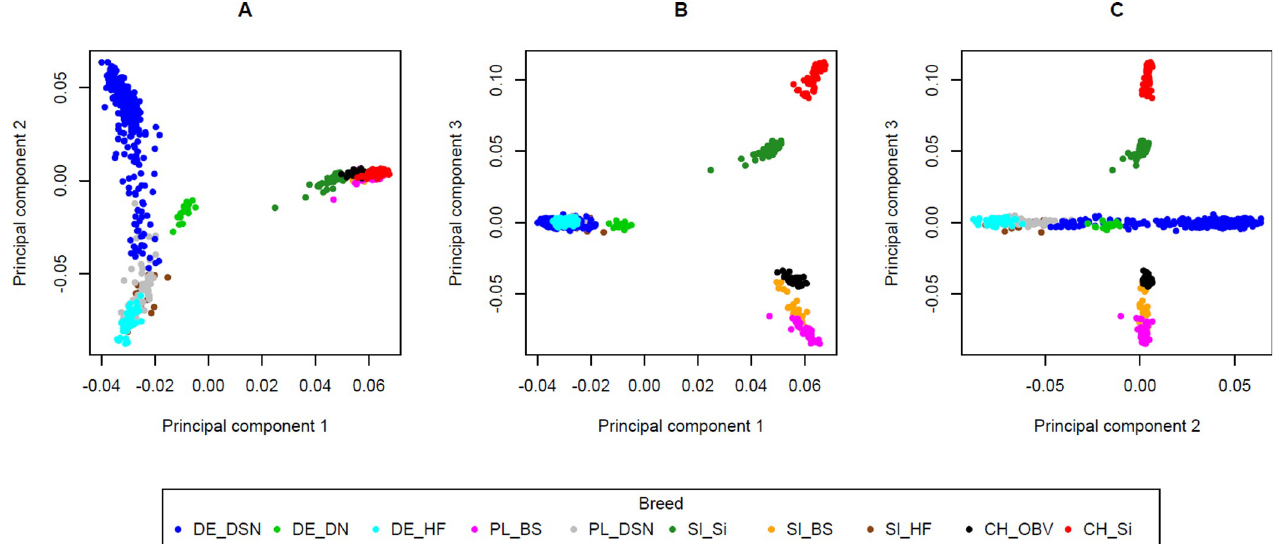
Fig 1. Plot of principal components 1 versus 2 (A), 1 versus 3 (B) and 2 versus 3 for the genomic relationship matrix based on 615 genotyped cows. DE_DSN = black and white dual-purpose (Germany); DE_DN = red and white dual-purpose (Germany); DE_HF = Holstein Friesian (Germany); PL_BS = Brown Swiss (Poland); PL_DSN = black and white dual-purpose (Poland); Sl_Si = Simmental (Slovenia); Sl_BS = Brown Swiss (Slovenia); Sl_HF = Holstein Friesian (Slovenia); CH_OBV = dual-purpose Original Braunvieh (Switzerland); CH_Si = Simmental (Switzerland). https://doi.org/10.1371/journal.pone.0221973.g001 Breed assignment. The breed assignment (Fig 2) identified ten cattle breeds with the larg- est ancestry proportions from the world reference dataset in Web-Interfaced Next Generation Database (WIDDE) [16] for the populations in this study. All populations from our study shared at least 57.83% of alleles with European breeds, affirming their European origin. The predominant genetic ancestry consisted of Holstein, Hereford, French Red Pied Lowland and